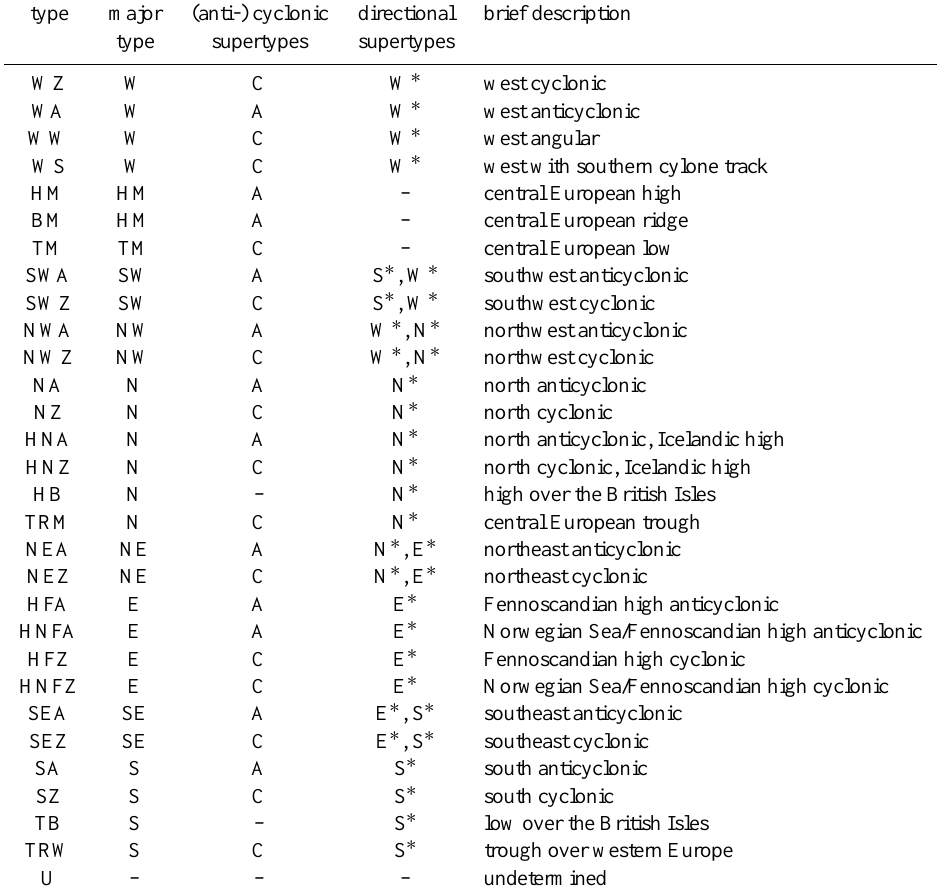
Table 2. List of the H&B types with their brief description and their attribution into the major types and supertypes.